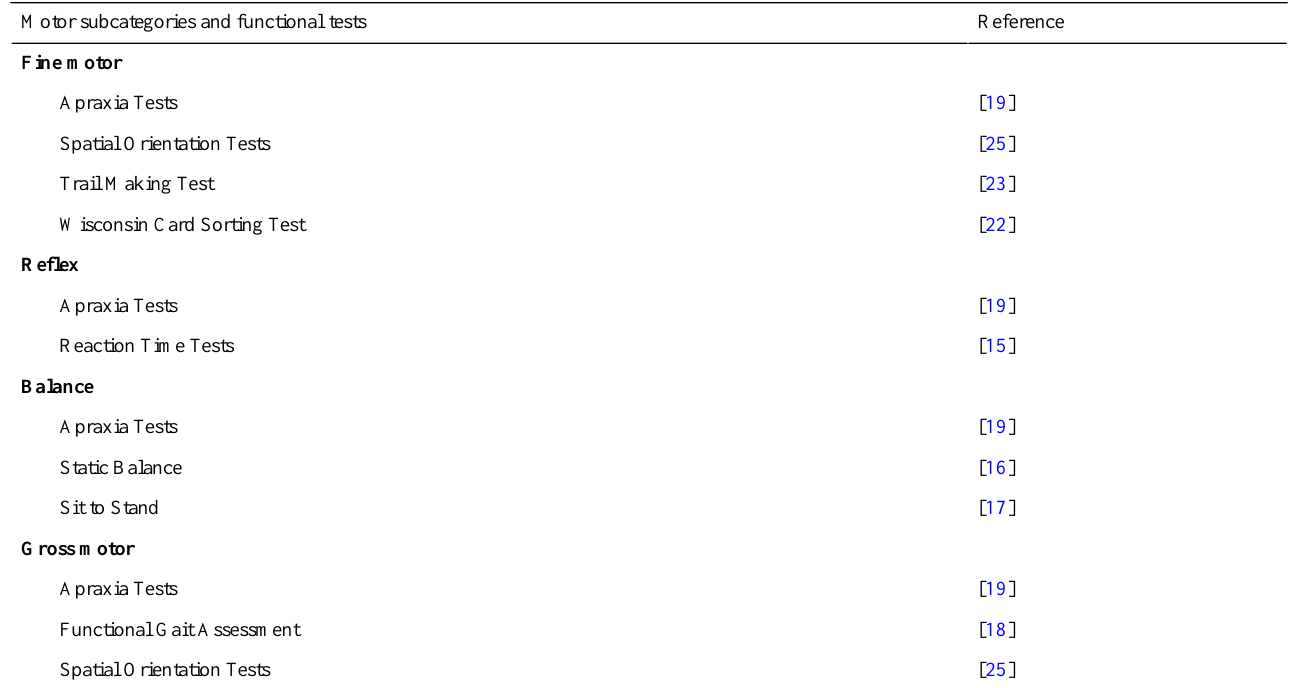
Table 5. Motor functional tests and assessment